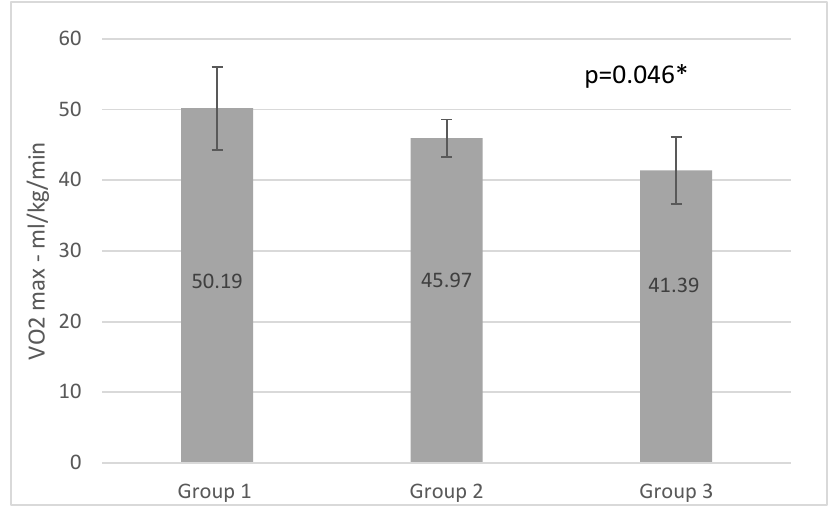
Figure 1. MET results of the groups (* p <0.05).